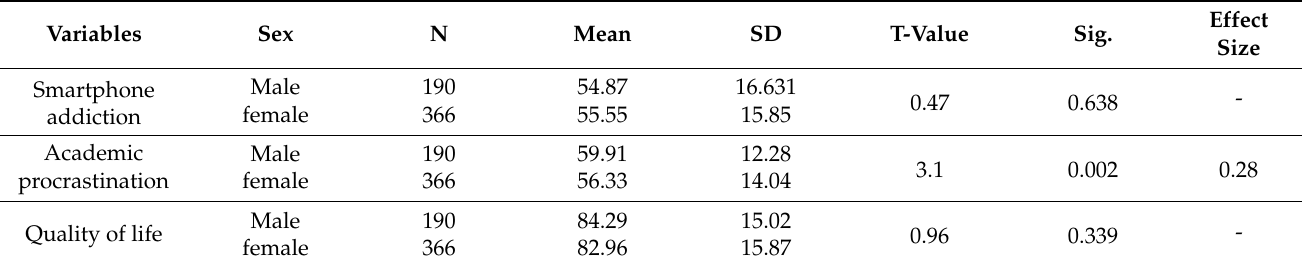
Table 2. The differences between males and females in smartphone addiction, academic procrastina- tion, and quality of life.